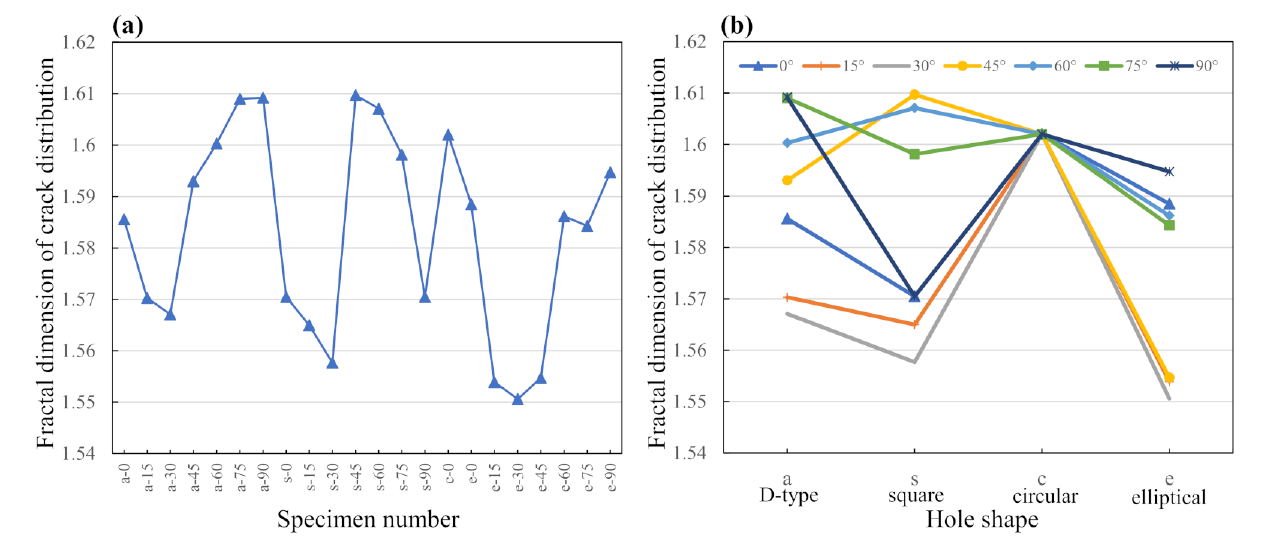
Figure 11. Fractal dimensions of crack distributions in pre-holed specimens at the ultimate failures under coupled biaxial loading and unloading condition for ( a ) all specimens and ( b ) the specimens with different shapes of holes with the same inclination